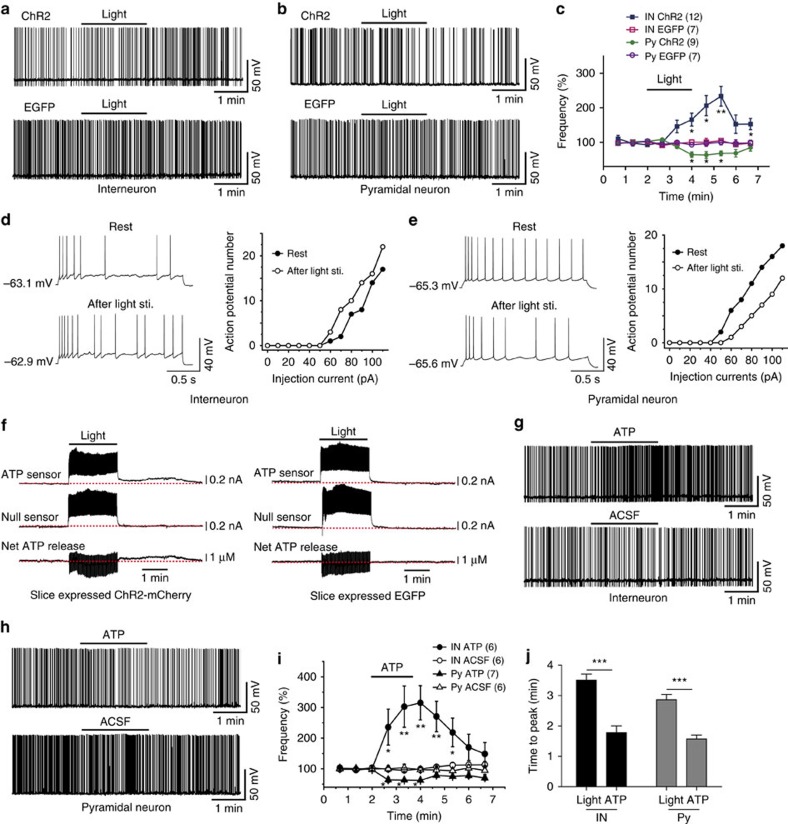
Light stimulation of ChR2-expressing astrocytes modulates neuronal excitability by releasing ATP.(a,b) Sample traces showing AP firing of interneurons and pyramidal neurons before, during and after 2 min of light stimulation (1 Hz, 0.5 s on and 0.5 s off) of astrocytes expressing ChR2 (upper) or EGFP (lower). (c) Summary data showing the time courses of AP frequency of interneurons (IN) and pyramidal neurons (Py) before, during and after light stimulation (bar) of slices expressing ChR2 or EGFP in astrocytes (two-way analysis of variance (ANOVA), for interneuron F(9,177)=2.98, P=0.0025; for pyramidal neuron F(9,130)=3.1, P=0.0021). Data are normalized to the AP frequency averaged from 2 min recording before light stimulation for each recording. (d,e) Left: representative APs of an interneuron (d) and a pyramidal neuron (e) in response to current injection before (upper) and after (lower) 2 min light stimulation (sti.). Right: plots of AP numbers from one typical neuron in response to a serious current injection before (filled symbols) and after (open symbols) light stimulation. (f) Represent traces recorded by ATP-specific biosensors. Net current evoked by light-induced ATP release was calculated by subtracting null sensor-recorded current from ATP sensor-recorded current. The red dotted lines at the bottom traces depict the basal ATP level before light stimulation. Of note, the spike-like noise that appeared during light stimuli was artefact elicited directly by light. (g,h) Sample traces showing AP firing in interneuron and pyramidal neuron before, during and after puffing 1 μM ATP (upper) or HEPES-buffered aCSF (lower) for 2 min. (i) Summary data showing the time courses of AP frequency of interneurons (IN) and pyramidal neurons (Py) before, during and after puffing 1 μM ATP (filled symbols) or HEPES buffered aCSF (open symbols) for 2 min (bar) (two-way ANOVA, for interneuron F(9,100)=2.21, P=0.0274; for pyramidal neuron F(9,105)=2.33, P=0.021). (j) Time to peak of responses induced by light stimuli and ATP application estimated by period from the time point starting to apply ATP or light to the time inducing its largest effect (Student's t-test, IN: P<0.0001; Py: P<0.0001). Error bars are defined as s.e.m. in all the figures. *P<0.05, **P<0.01, ***P<0.001